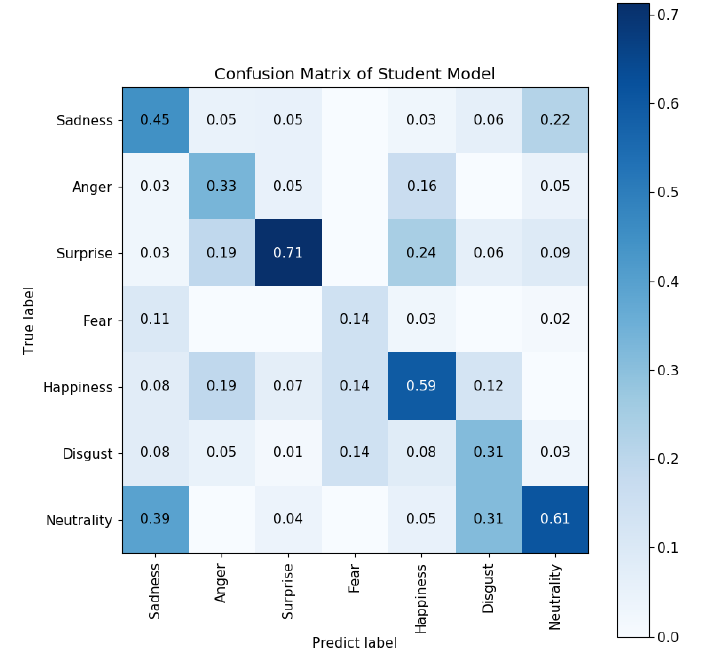
Figure 8. Confusion matrix of our student model.